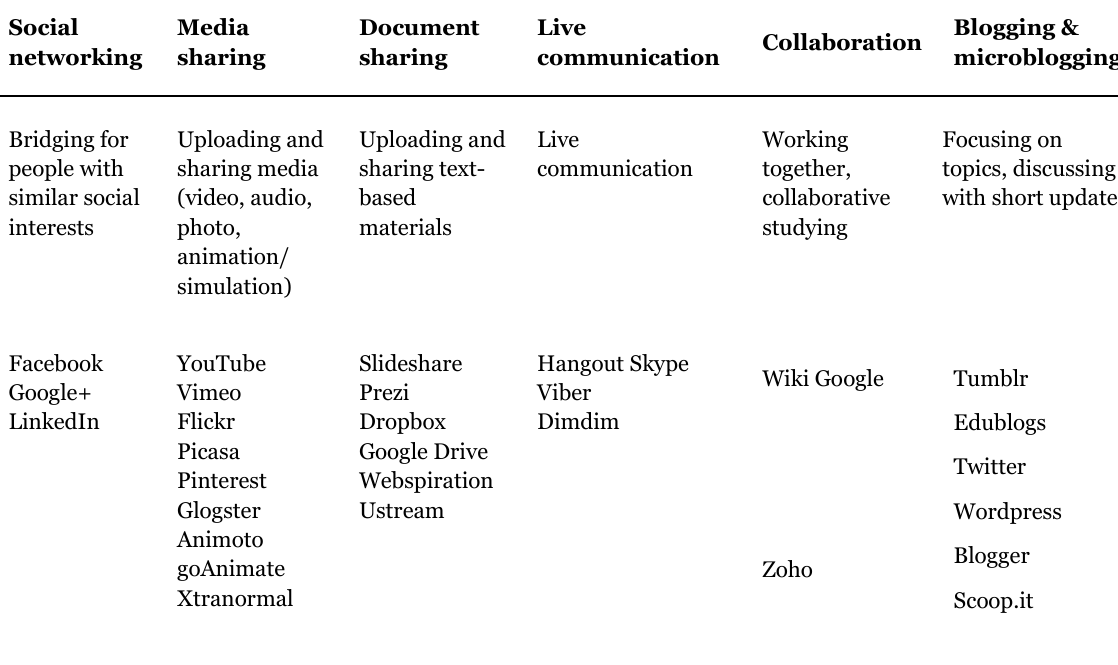
Categorization of Social Media Types (Including Sample